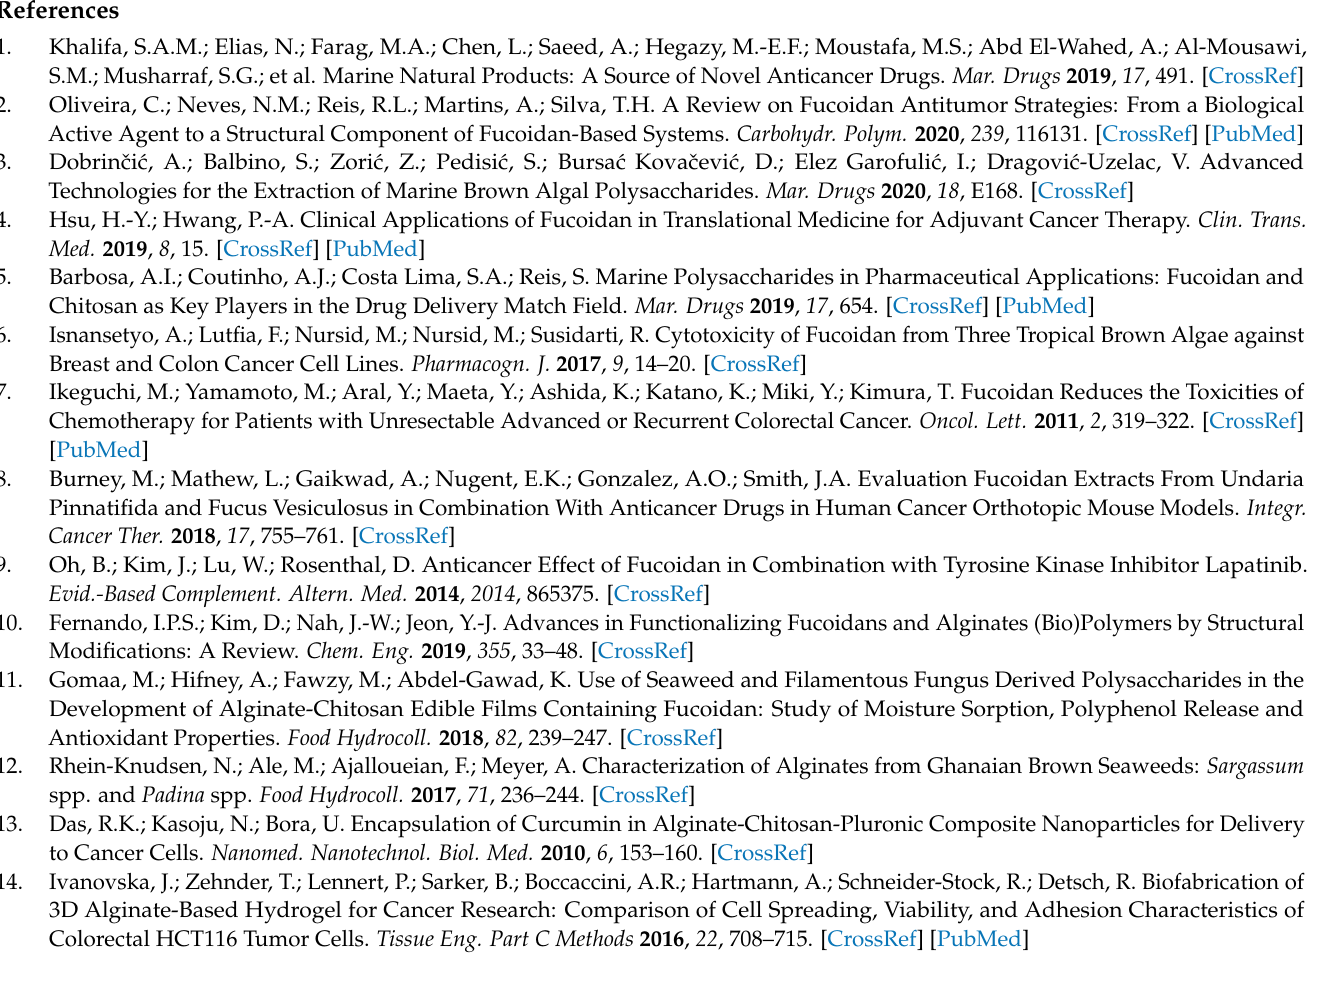
detector, Figure S3: Cell cycle gating of HCT-116 treated with fucoidan and alginate isolated from C. sinuosa, together with their combinations with vC, Table S1: 1 H and 13 C NMR chemical shifts of purified (A) alginate and (B) fucoidan recorded at 70 ◦ C, Table S2: Fucoidan and alginate IC50 against different cancer cell lines (HCT-116, MCF7, and HeLa) at 24 and 48